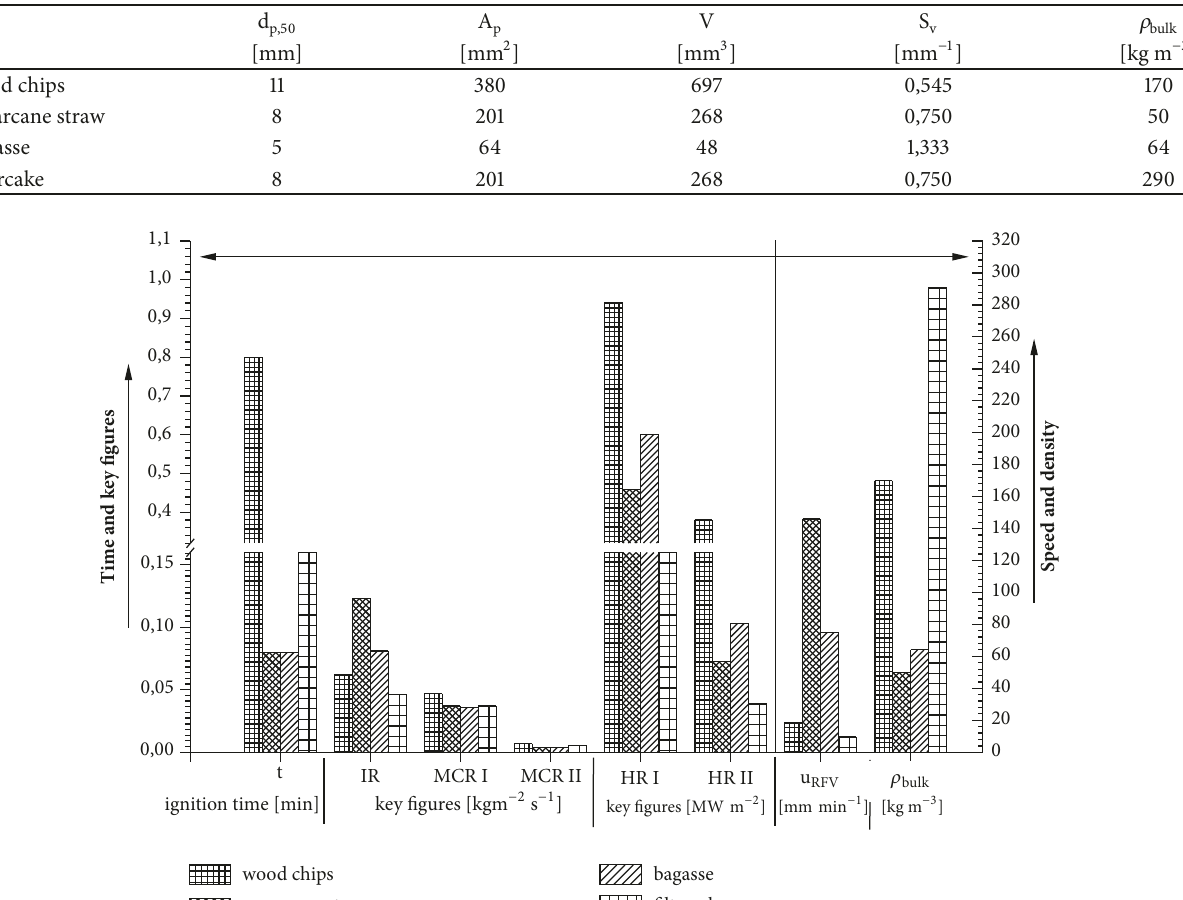
Table 3: Physical properties of the fuels.